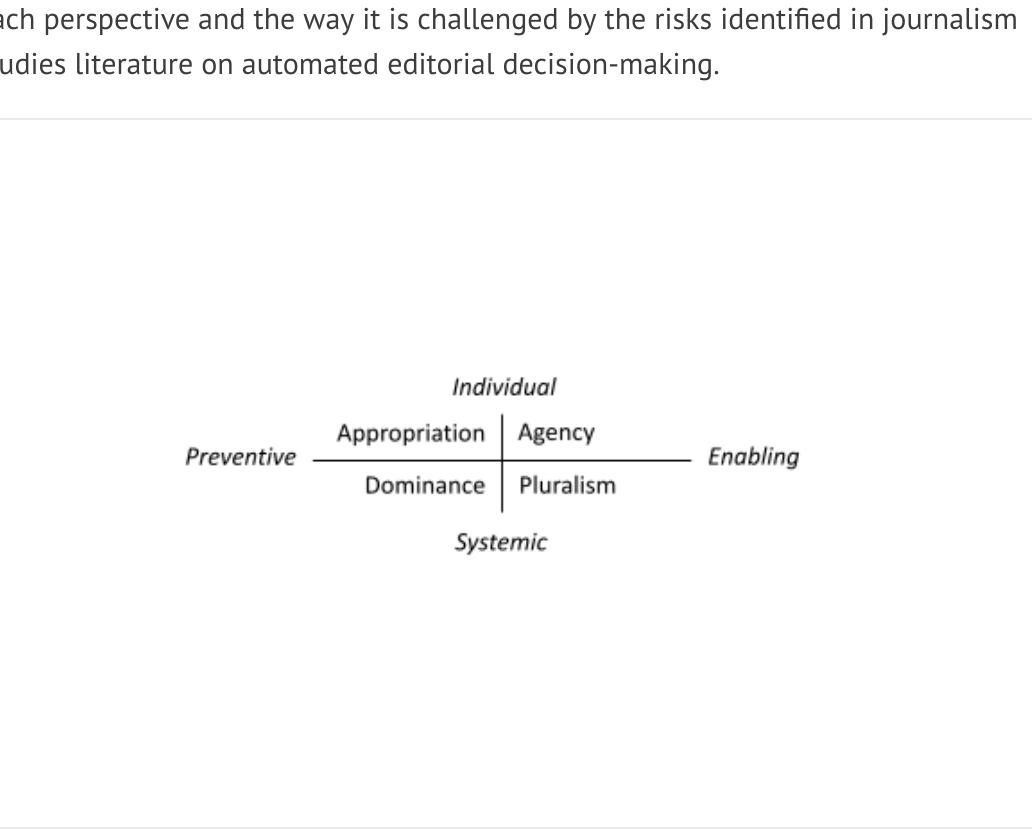
FIGURE 1: Normative perspectives on editorial independence in European media policy (source: elaborated by